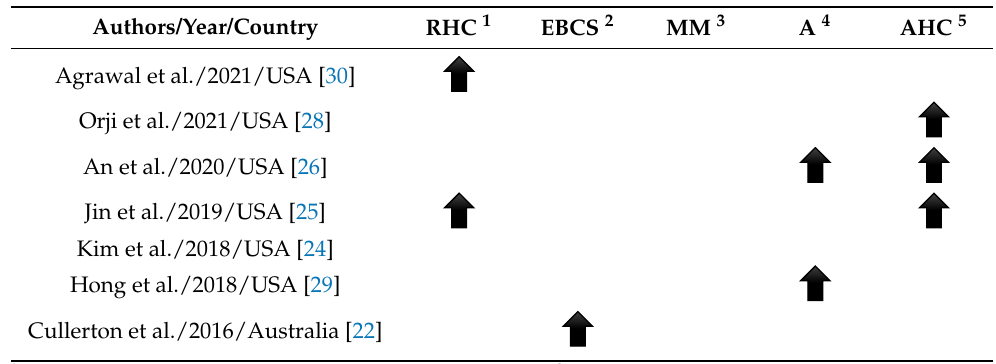
Table 4. Adherence to breast cancer–screening program according to information, confidence and involvement in health.